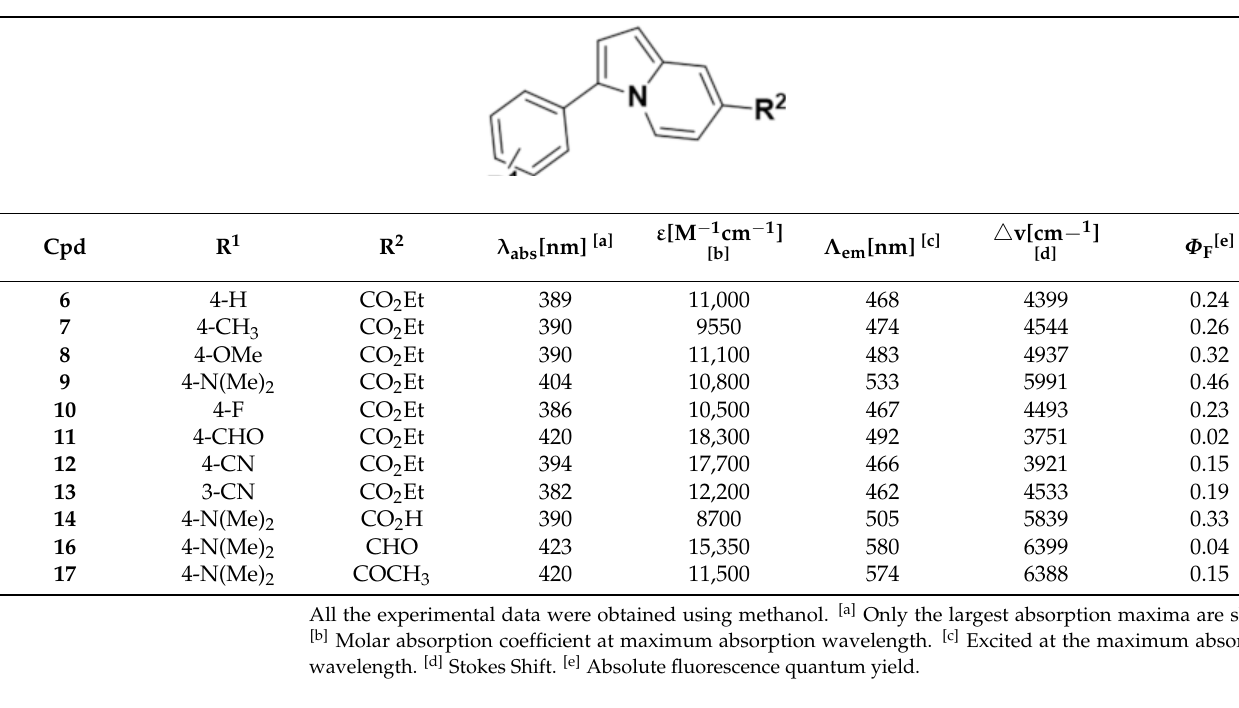
Table 1. Photophysical properties of 3,7-disubstituted indolizine compounds.